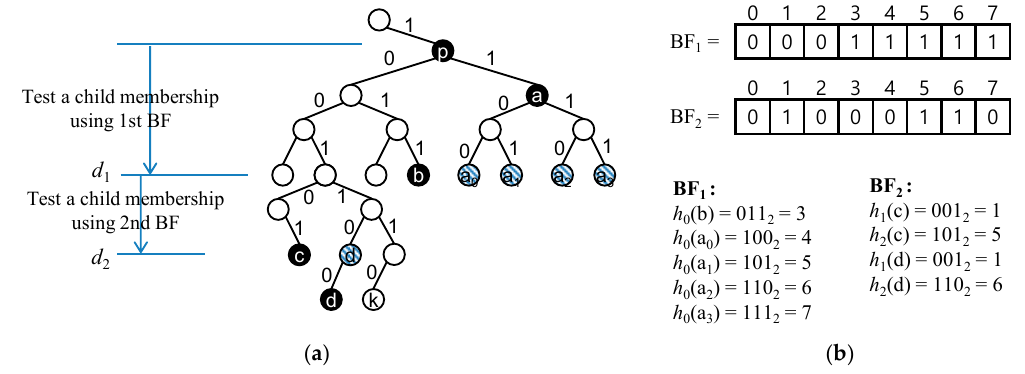
Figure 4. An example of a two-level Bloom filter for a prefix p : ( a ) a trie; and ( b ) a two-level Bloom filter.